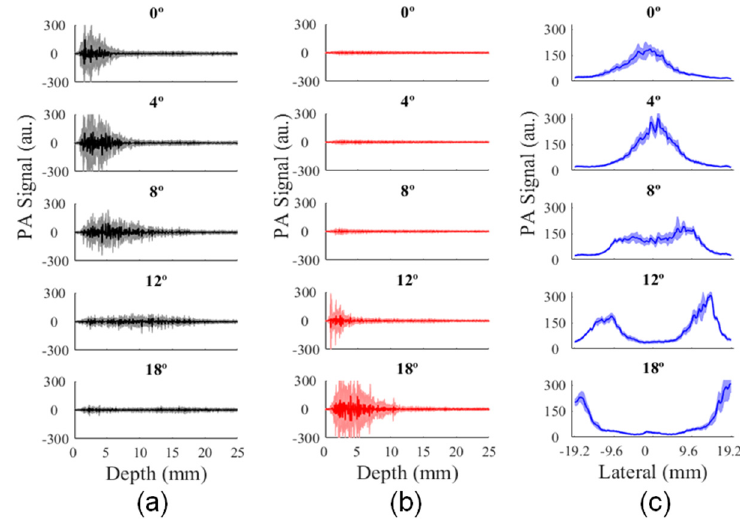
Figure 8. Average PA signal as a function of the illumination angle, along the axial direction at ( a ) central (ROI-1) and ( b ) peripheral ROIs (ROI-2 and ROI-3); ( c ) average PA signal magnitude along lateral direction for depths ranging from 0 mm to 2 mm.